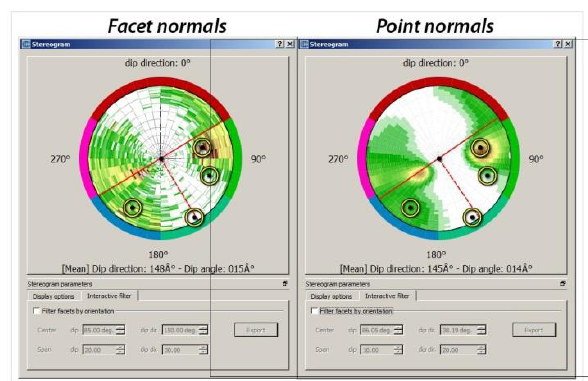
Figure 4. Stereograms of facets (left) and of point normal. Circles represent the dominant families surveys along the scan